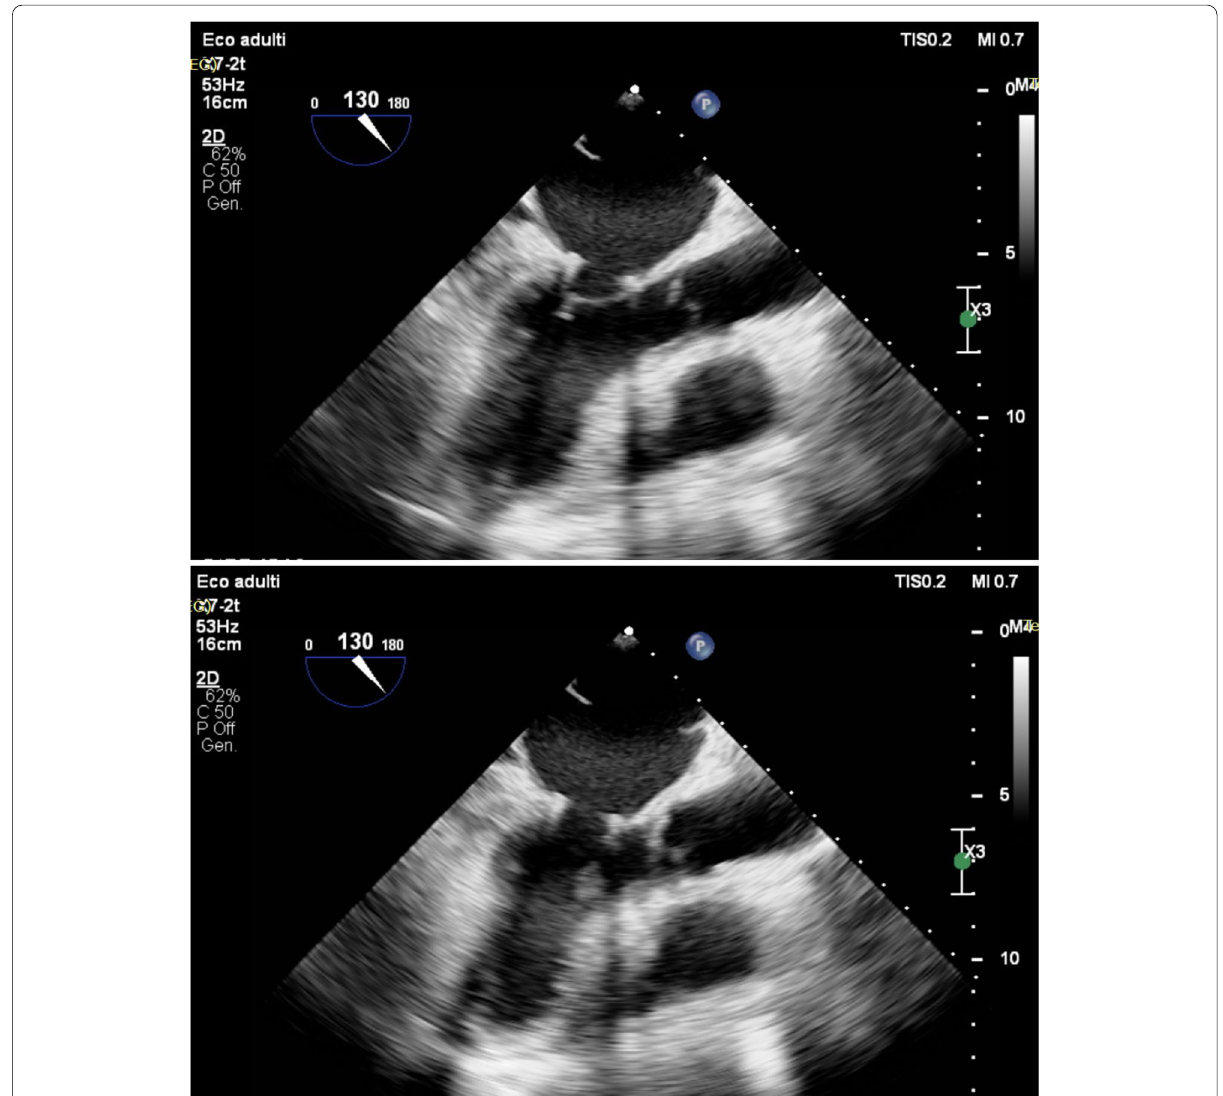
Fig. 3 Post-operative echography showing minimal residual fenestration in left